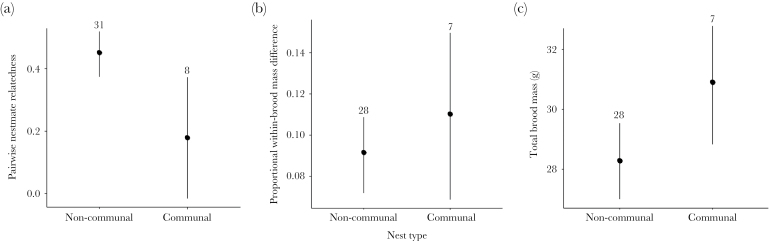
Brood-level differences in (a) relatedness, (b) nestling size asymmetry, and (c) total brood mass between noncommunal and communal nests (each with 2 offspring) in the Seychelles warbler. Dots and lines denote mean and standard error, respectively, numbers represent sample size per group.